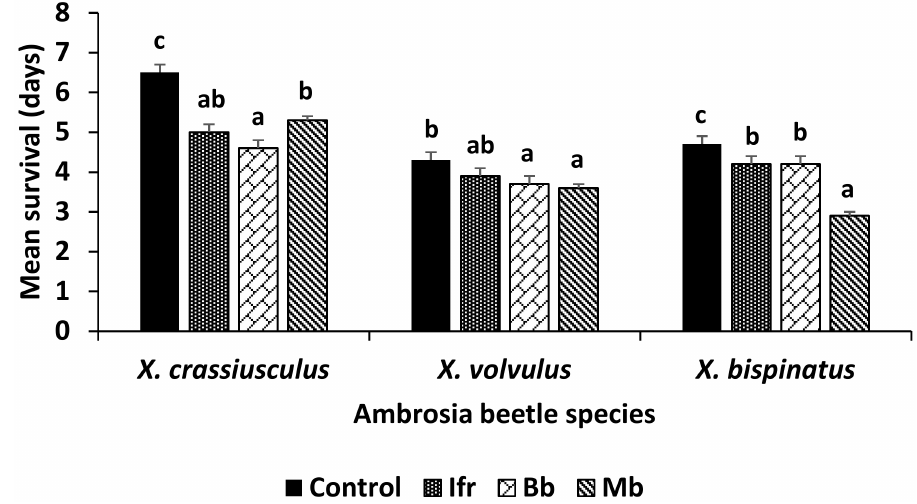
Figure 2. Comparison of the mean ( ± SEM) days of survival for Xylosandrus crassiusculus ( n = 30 per treatment), Xyleborus volvulus (n = 50 per treatment) and Xyleborus bispinatus ( n = 40 per treatment) after exposure to a filter paper disk treated with 100 µ L of one of three fungal suspensions (2.4 × 10 6 spores/mL) or distilled water for seven days. Control = distilled water only, Ifr = Isaria fumosorosea (PFR-97 20% WDG), Bb = Beauveria bassiana (BotaniGard ES), Mb = Metarhizium brunneum (Met52 EC). Bars for each beetle species not followed by the same letter are significantly different (Tukey’s HSD test, p <